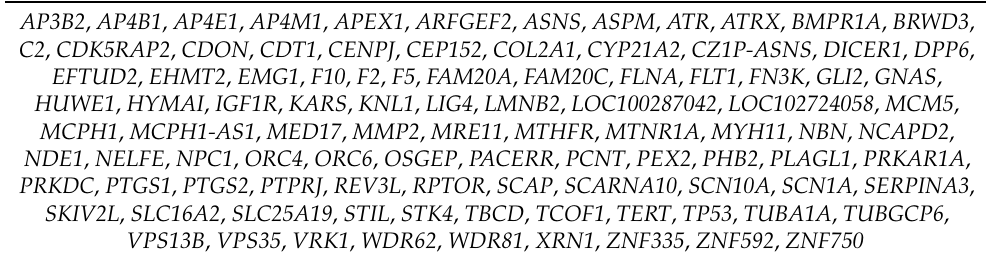
Table 1. A total of 99 disease-causing genes that were related with the clinical features of the fetus. AP3B2 , AP4B1 , AP4E1 , AP4M1 , APEX1 , ARFGEF2 , ASNS , ASPM , ATR , ATRX , BMPR1A , BRWD3 , C2 , CDK5RAP2 , CDON , CDT1 , CENPJ , CEP152 , COL2A1 , CYP21A2 , CZ1P-ASNS , DICER1 , DPP6